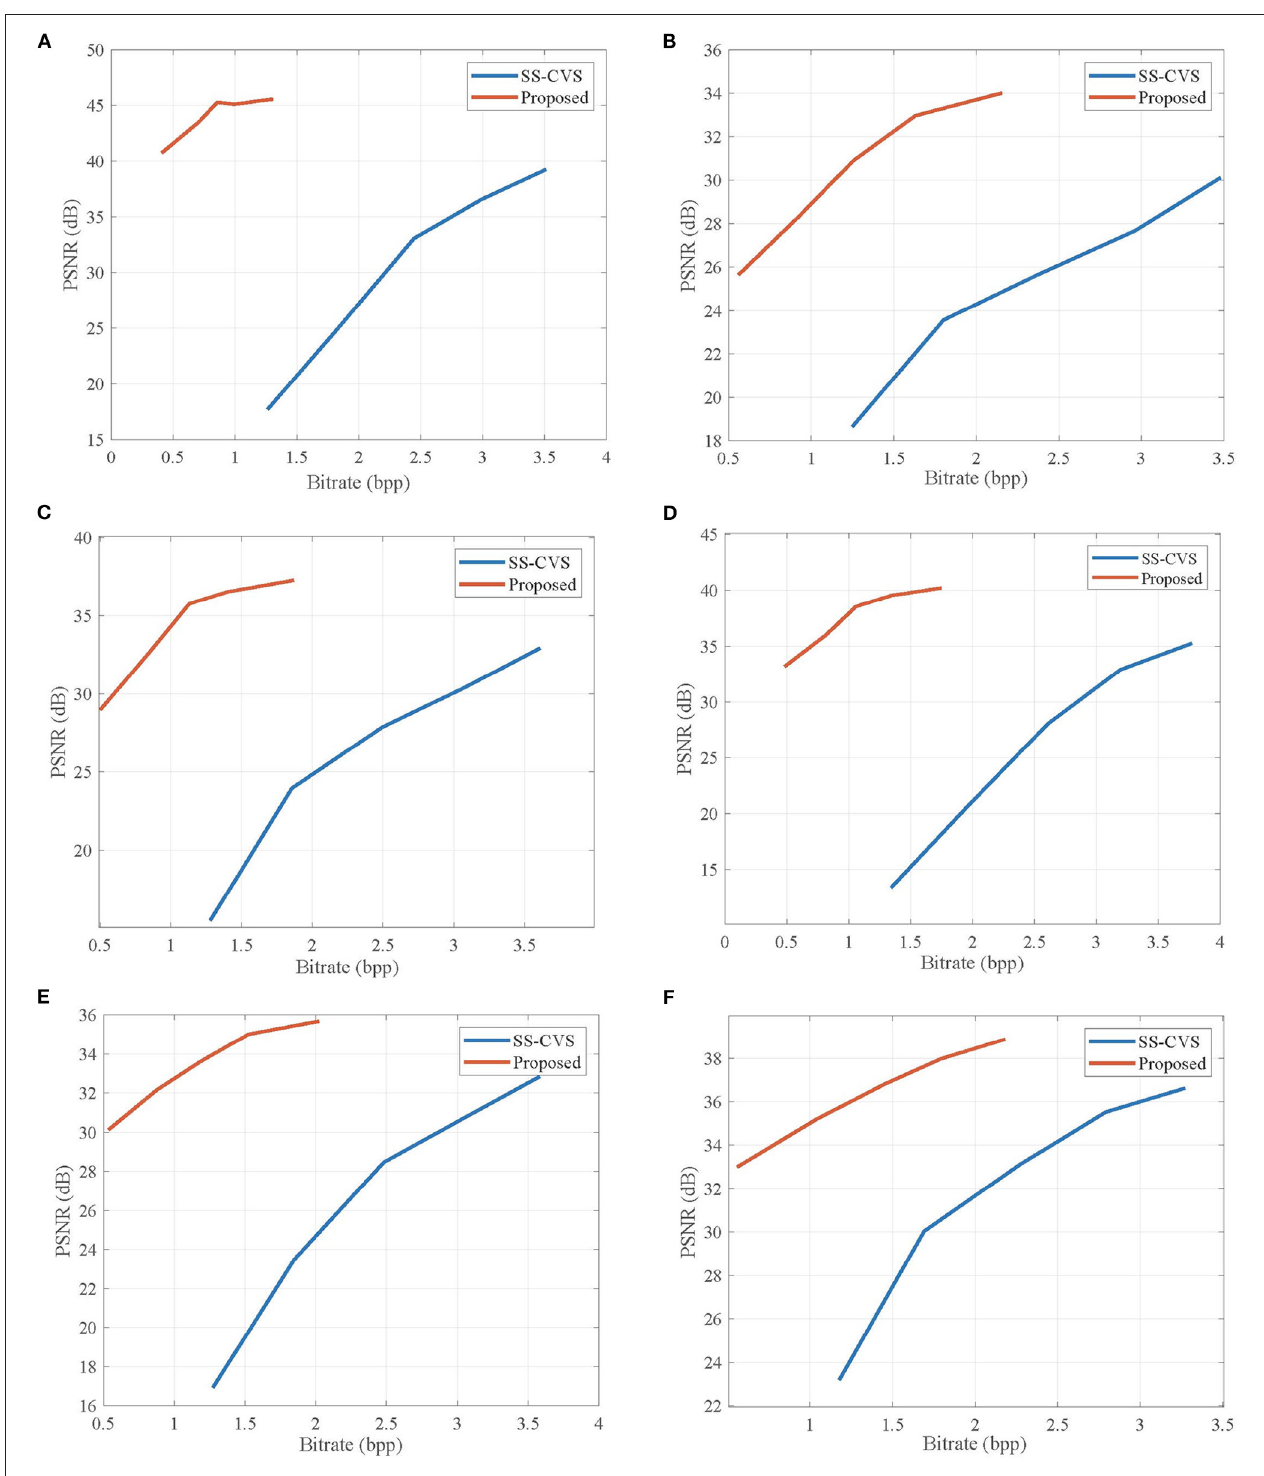
FIGURE 12 | Rate-distortion curves obtained by the proposed CVS system and Scalable Structured CVS (SS-CVS) (Li et al., 2020) for (A) Akiyo , (B) Bus , (C) Football , (D) Foreman , (E) BlowingBubble , and (F) ParkScene sequences. Note that the length L of GOP is set to be 10.